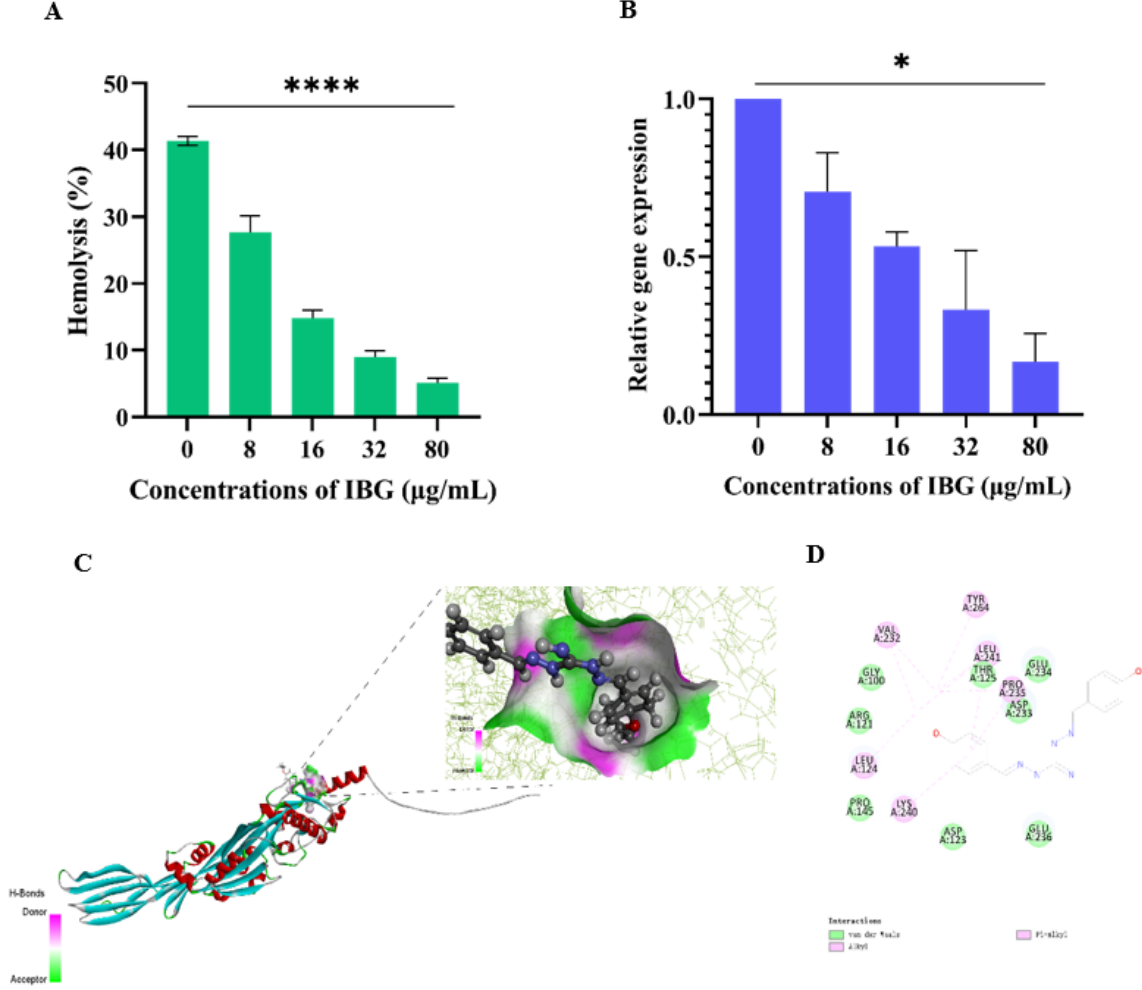
Figure 3. IBG alleviated the hemolytic activity of S. suis ATCC 43765. ( A ) Hemolytic activity of supernatants of S. suis ATCC 43765 cultures treated with different concentrations of IBG. ( B ) Relative expression levels of the Sly gene of S. suis ATCC 43765 in the presence of IBG. ( C , D ) The interaction pattern of IBG and Sly proteins. *, p < 0.01, ****, p <